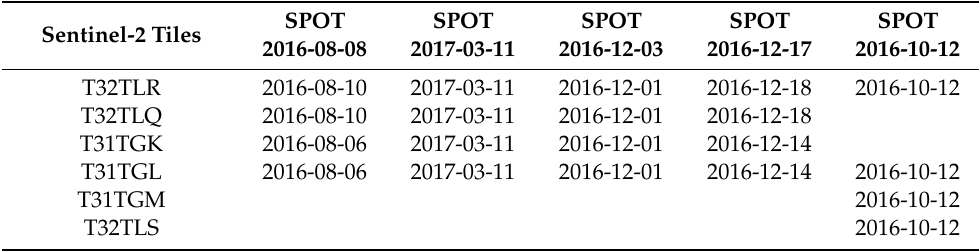
(dates are given in format